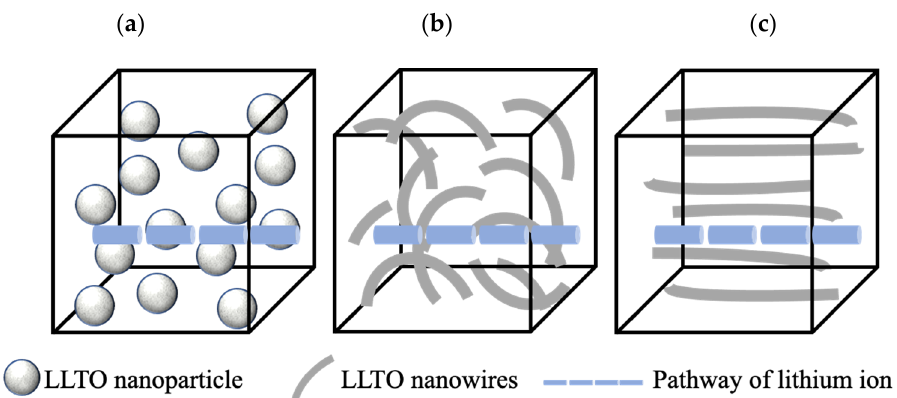
Figure 5. Schematic images of pathways of lithium ions when LLTO as: ( a ) isolated nanoparticles; ( b ) random nanowires; and ( c ) well aligned nanowires.